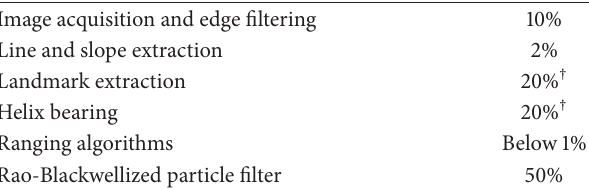
Table 1: CPU utilization of the proposed